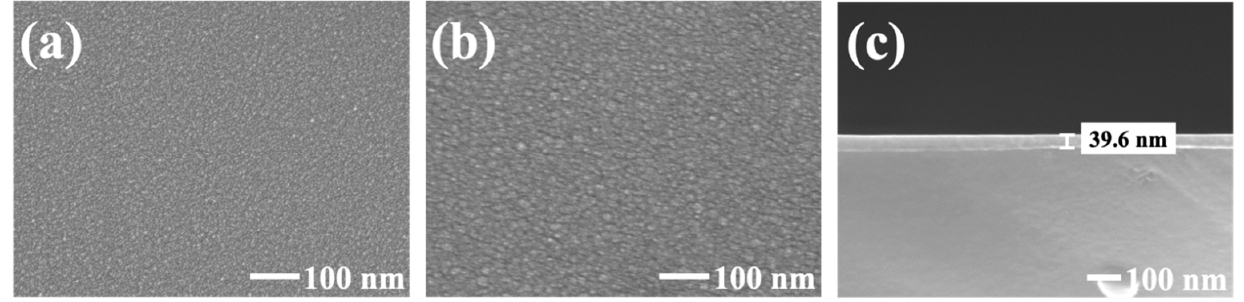
Figure 2. SEM plan view images of the ALD-grown Al 2 O 3 thin films on ( a ) single crystalline Si wafer, ( b ) glass. ( c ) SEM cross-section view image of the ALD-grown Al 2 O 3 thin films on a glass.